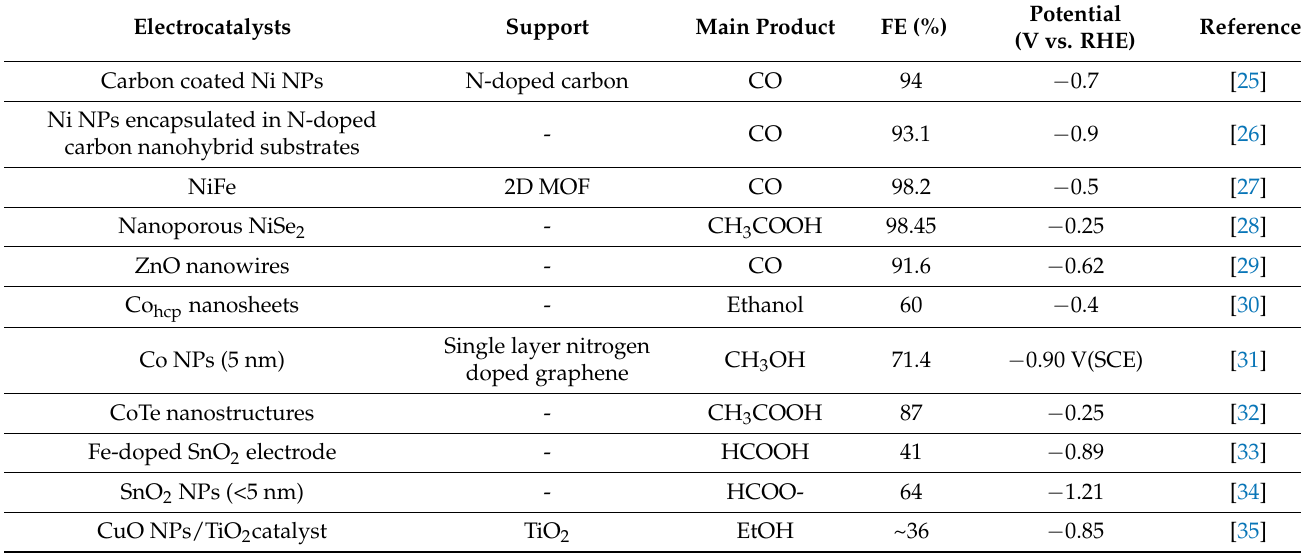
Table 3. Some examples of different non-noble metal-based electrocatalysts for CO 2